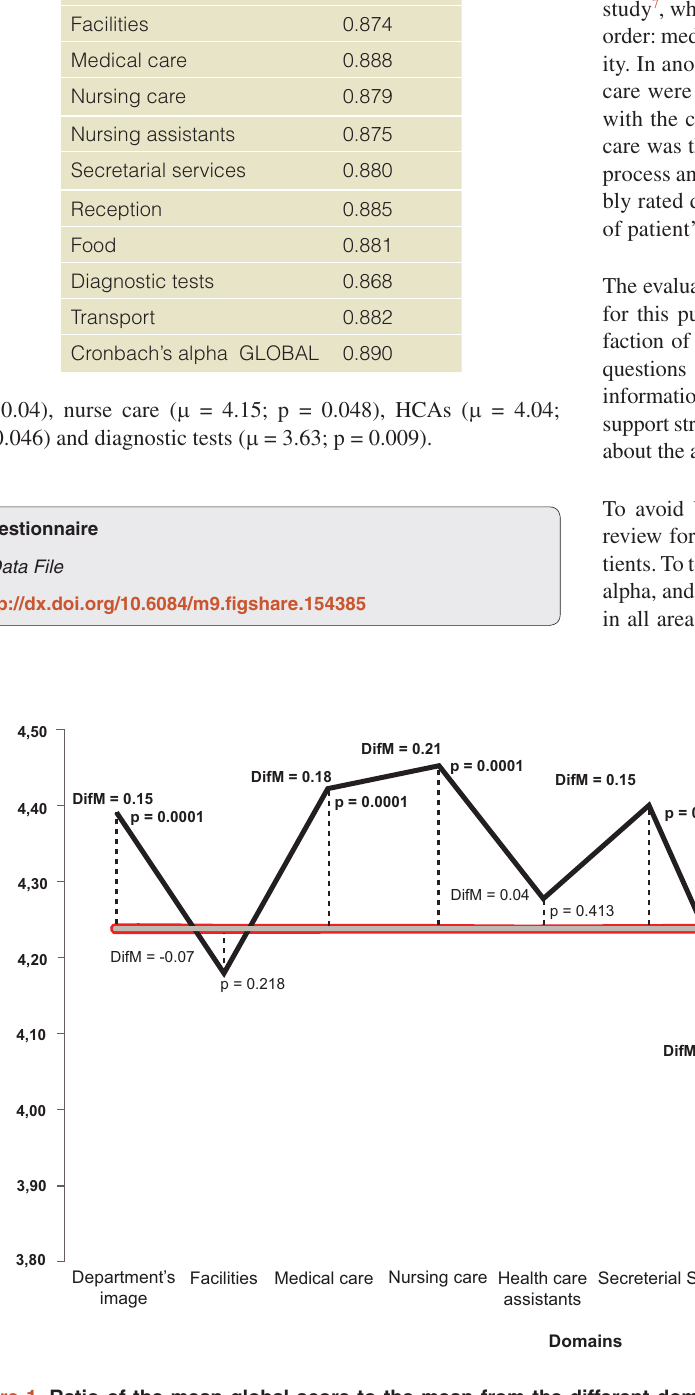
Figure 1. Ratio of the mean global score to the mean from the different domains of the questionnaire. Student t test or analysis of variance (ANOVA) with the Tukey’s multiple comparison test performed.